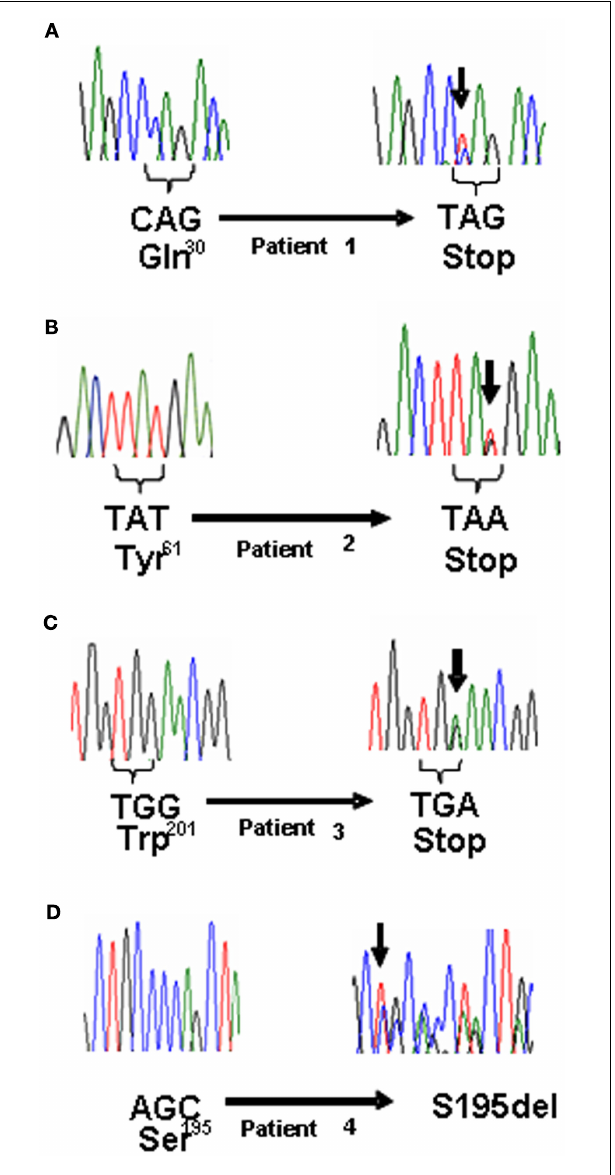
FIGURE 1 | (A) Electropherogram showing the germline mutation denoted with arrow: wild type (left) and mutated patient 1 (right). (B) Electropherogram of wild type (left) and mutated patient 2 (right). (C) Electropherogram of wild type (left) and mutated patient 3 (right). (D) Electropherogram of wild type (left) and mutated patient 4